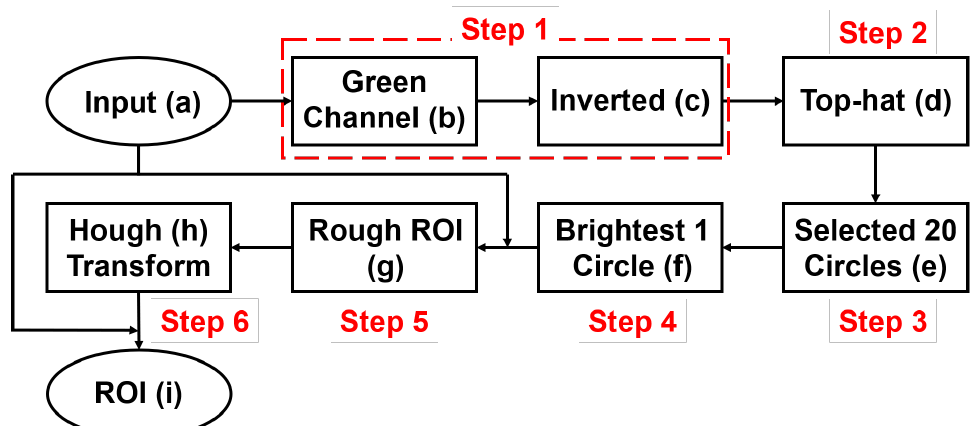
Figure 8. Flowchart of ROI detection: ( a – i ) correspond to images in Figures 9 and